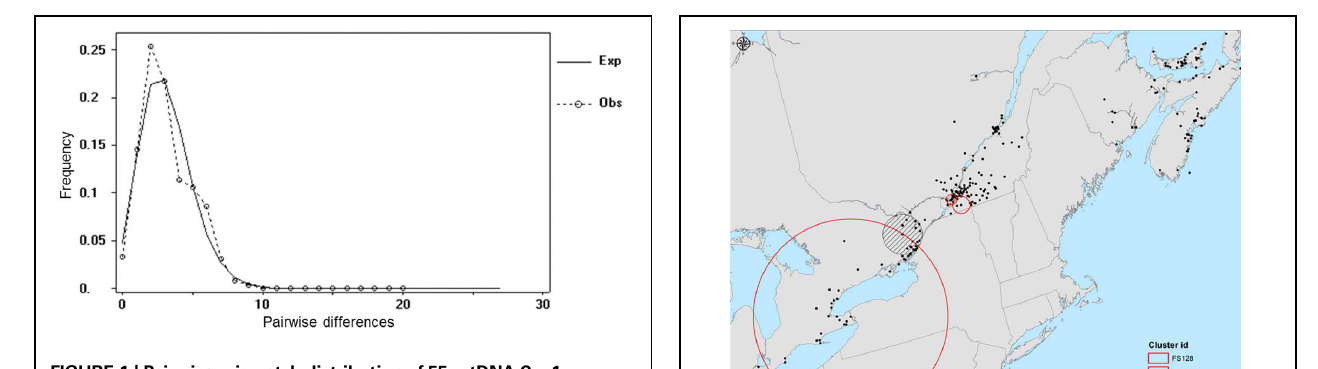
FIGURE 1 | Pairwise mismatch distribution of 55 mtDNA Cox1 haplotypes of I. scapularis in Canada (Obs) compared against the expected distribution for a population under expansion (Exp). This graph represents a re-analysis of the data in Mechai et al. (2013) using only one example of each haplotype, to clarify the similarity of observed and expected frequency distributions.